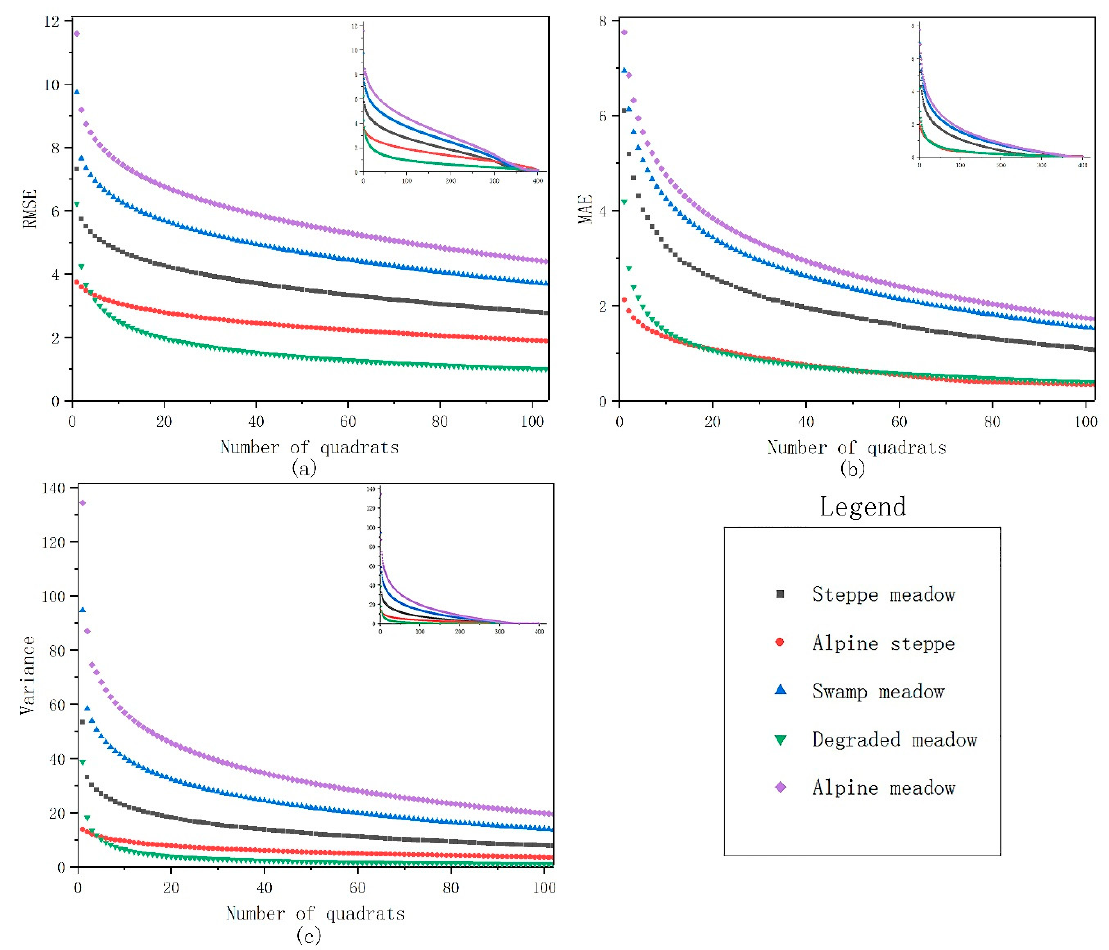
Figure 7. The relationship between the number of di ff erent quadrats and the error of survey results.